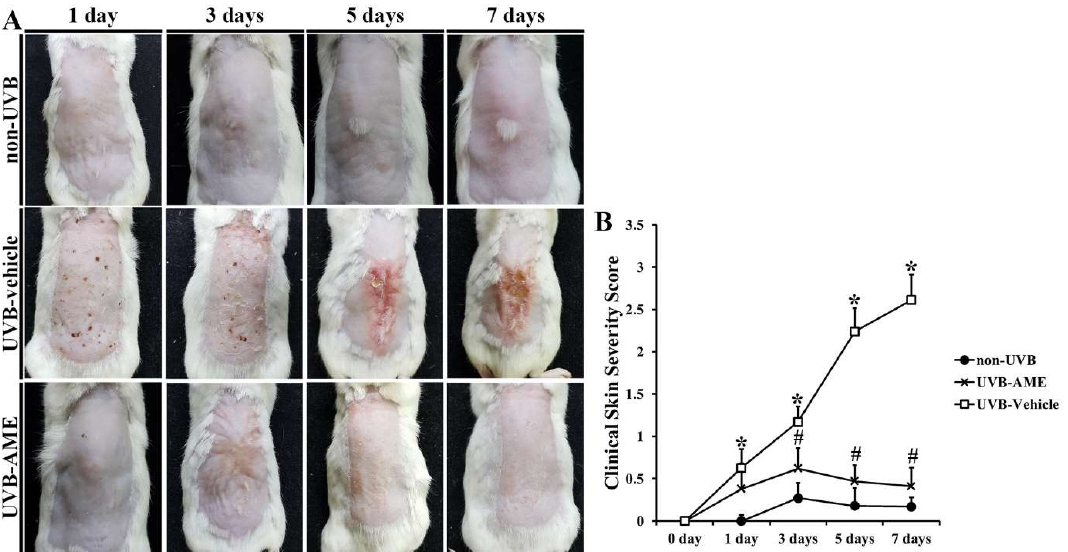
Figure 2. ( A ) Images of the dorsal skin in the non-ultraviolet B -(UVB), UVB-vehicle and UVB-AME groups at 1, 3, 5 and 7 days after UVB irradiation. In the UVB-AME group, the clinical skin severity (CSS) is remarkably attenuated compared to that in the UVB-vehicle group. ( B ) CSS score in each group at 1, 3, 5 and 7 days after UVB irradiation. The CSS score in the UVB-AME group is decreased from 3 days after UVB irradiation. Bars indicate the means ± SEM (n = 10 in each group, * p < 0.05 vs. non-UVB group, # p < 0.05 vs. UVB-vehicle group).